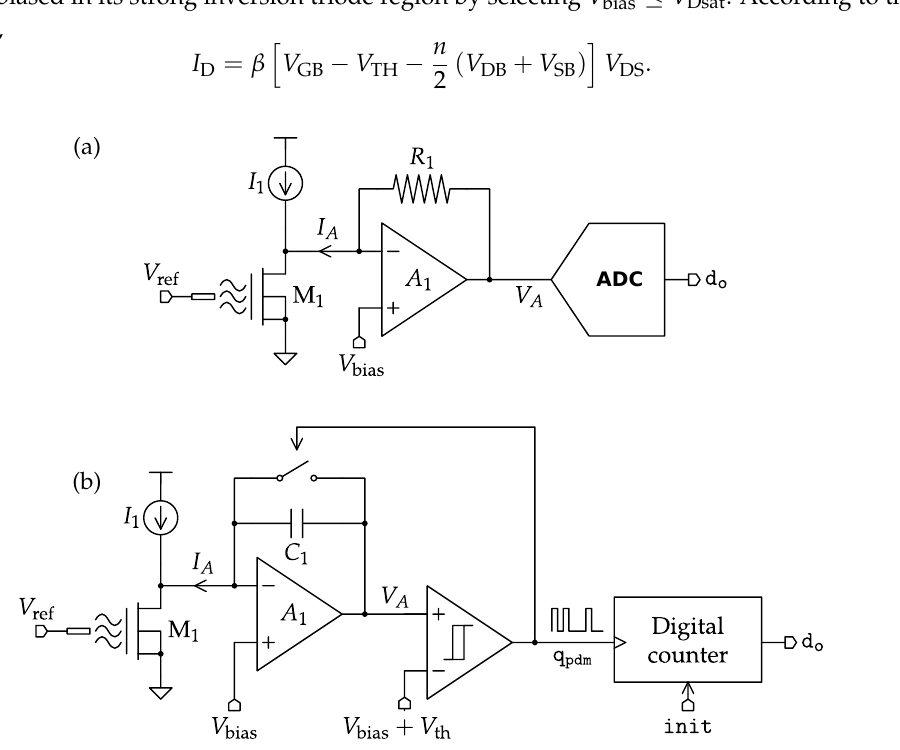
Figure 21. Amperometric ISFET readout interfaces: ( a ) classic resistive TIA analog front-end and ( b ) asynchronous pulse-density modulation (PDM) analog-to-digital converter with